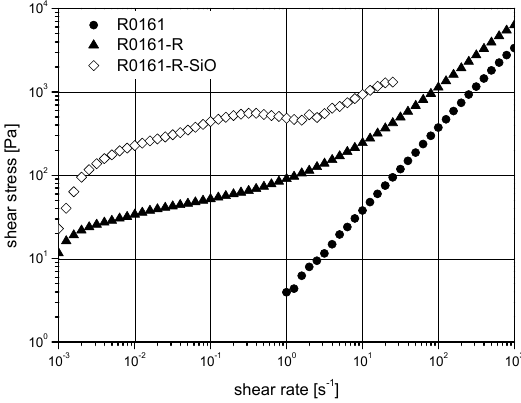
Figure 4. Shear rate sweeps of REPDTP and its modifications. Figure 4 . Shear rate sweeps of REPDTP and its modifications.